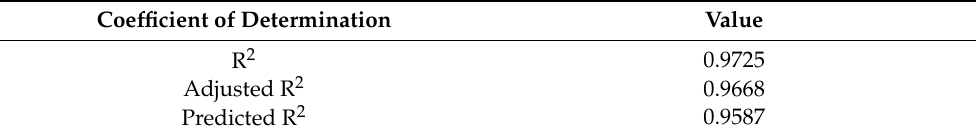
Table 6. Coefficient of determination for BSFC. Coefficient of Determination